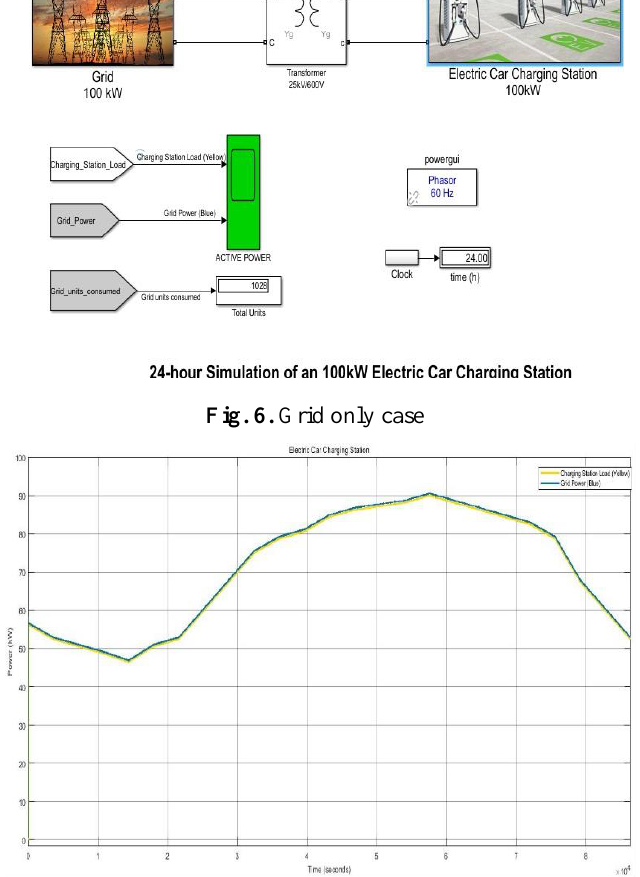
Fig. 7. Results when only grid supply power